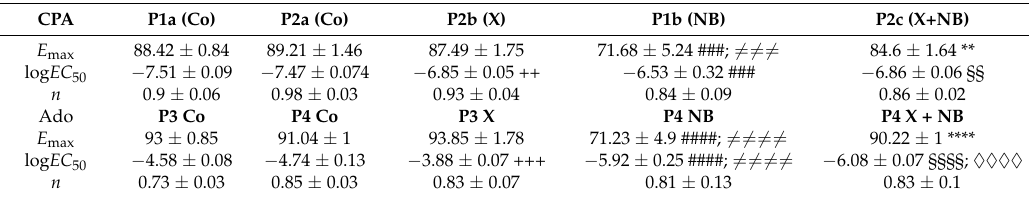
Table 2. The Hill parameters of concentration-response ( E / c ) curves generated with adenosine and CPA in the different groups under different